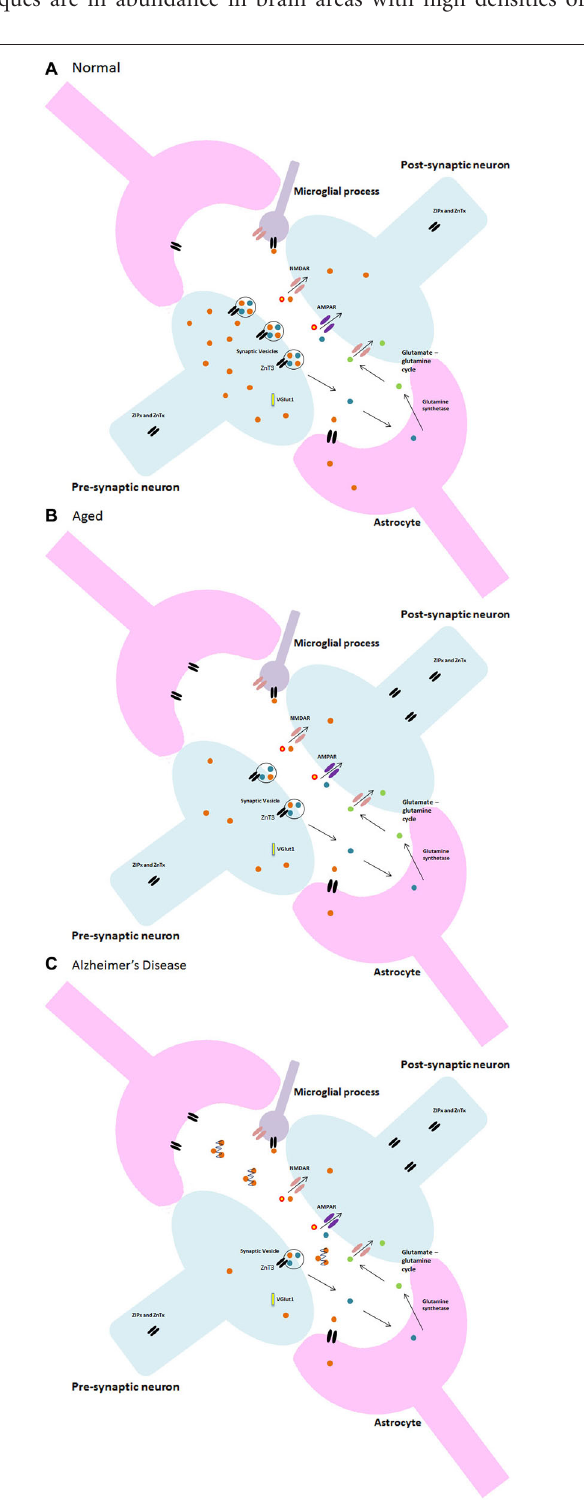
FIGURE 2 | Proposed glutamatergic synapse structure. Including astrocytes and microglia.